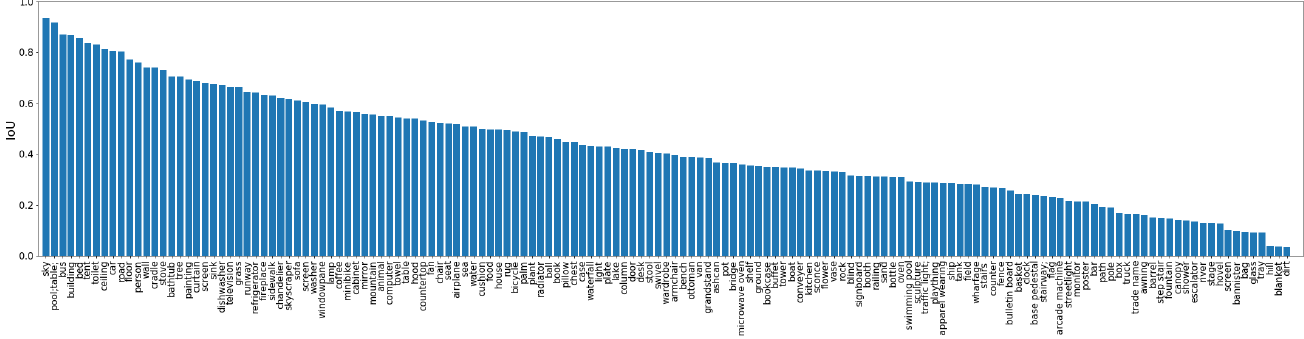
Figure 8. Detailed IoU on the 150 categories given by DilatedResNet50+Resnet50+PPM model. The best segmented categories are big objects, and the worst segmented categories are objects that are usually small and have few